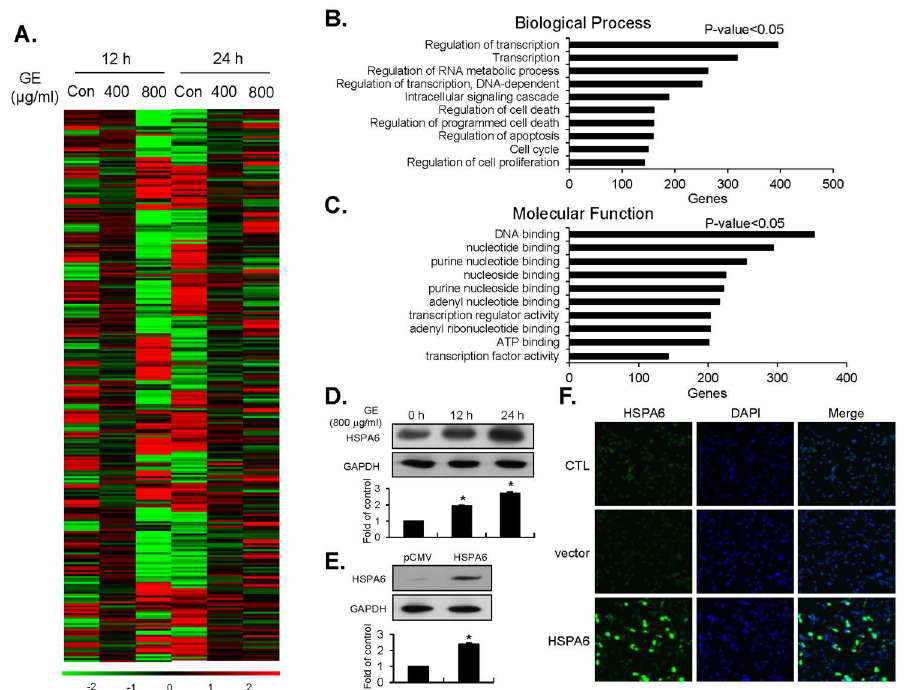
Fig 4. Gene expression patterns in EJ cells treated with GE. (A) Clustergram of differentiallyexpressed genesby GE treatment was producedusing microarray analysis. The red and green colors indicatehigh and low expressionof particulargenes, respectively.(B, C) Differentiallyexpressedgenes upon GE treatments were categorized by their biologicalprocesses(BP) and molecularfunctions (MF) through GO term enrichment analysis. (D) The expressionof HSPA6 in responseto GE treatment at different time points was measuredby immunoblots. (E) Transfectionefficiency of HSPA6 cDNA gene was evaluatedby transient transfectioncomparedto an empty vector (EV), pCMV. (F) After transfectionof the HSPA6 gene, expression levels of HSPA6 were confirmedby